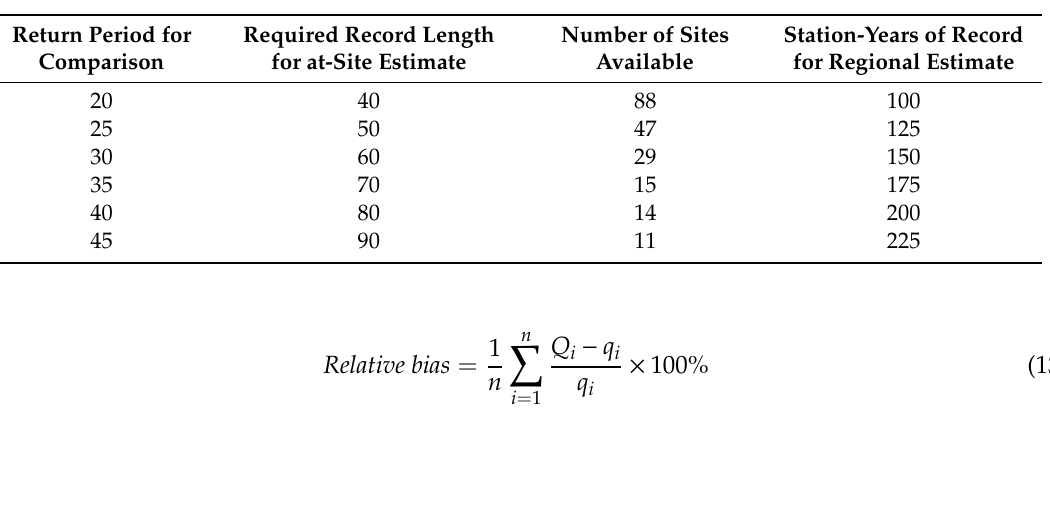
Table 1. Required record length for at-site and regional estimate at di ff erent return periods used in